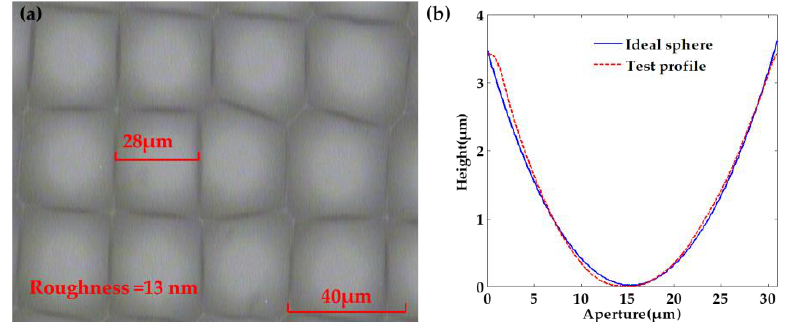
Figure 9. Micrographs and simulation profiles: ( a ) microscopic image of rectangular rMLA; and ( b ) comparison of microlenses profile and ideal sphere.